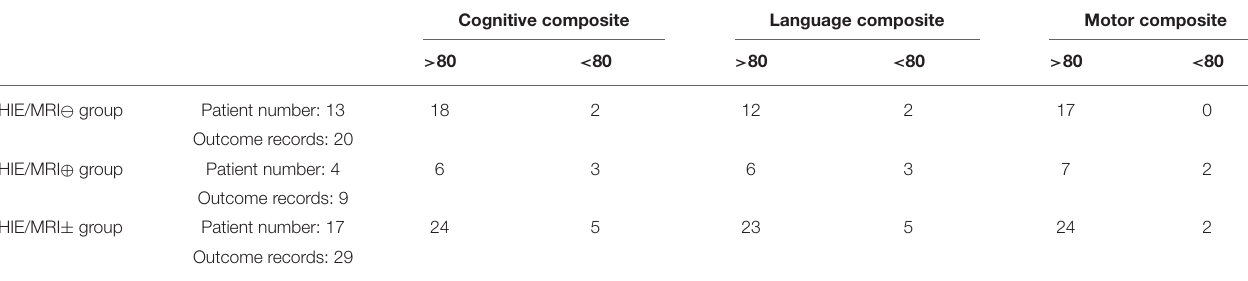
TABLE 1 | The summarization of the outcome data. Cognitive composite Language composite Motor